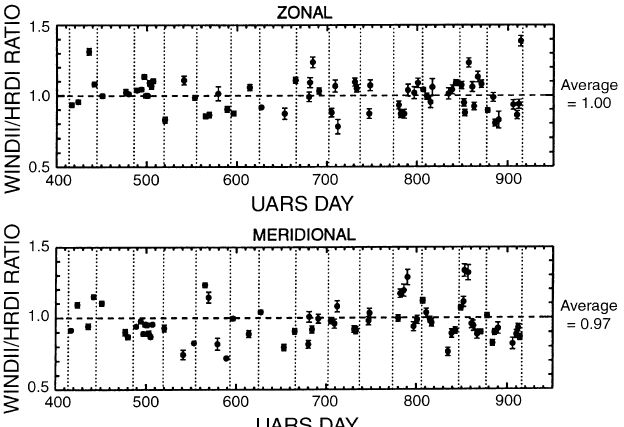
Fig. 6. Slopes obtained from the regression analysis as a function of UARS day number, for both the zonal ( upper panel ) and the meridional wind component ( lower panel ) at an altitude of 95 km. The vertical dotted lines indicate yaw maneuver days